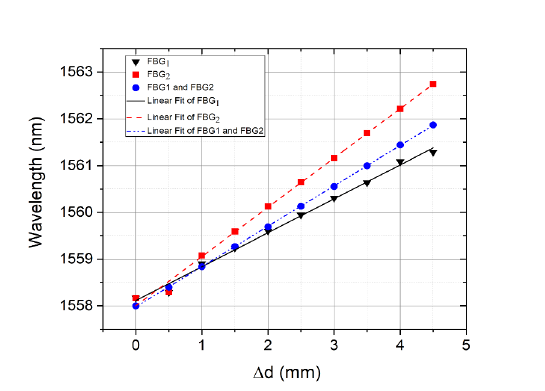
Figure 2. Wavelength shift caused by the diameter reduction.